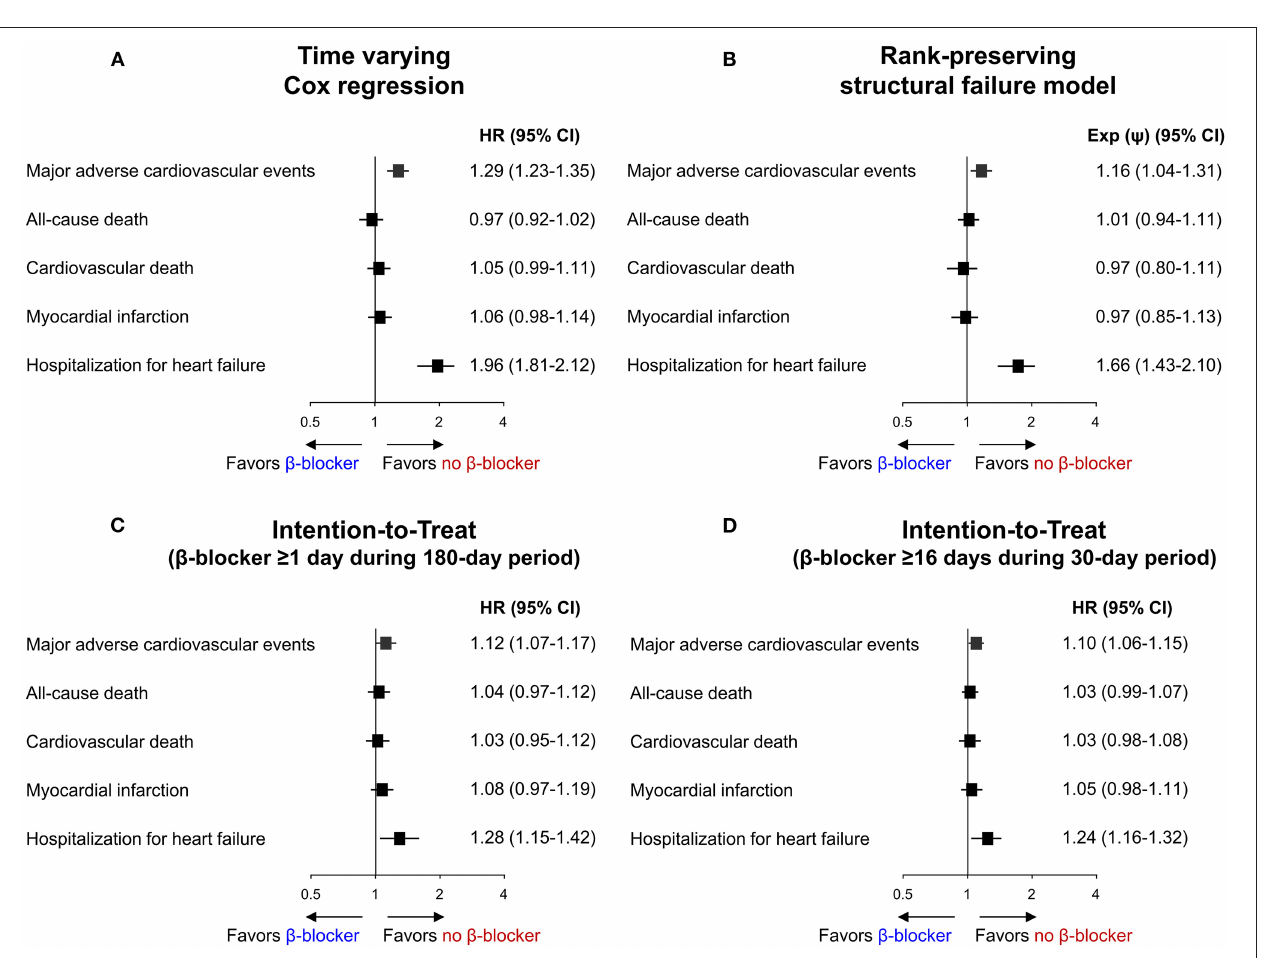
FIGURE 5 | Sensitivity analysis for primary and secondary outcomes. Risk of primary and secondary outcomes according to beta-blocker treatment analyzed by (A) Time varying Cox regression, (B) Rank-preserving structural failure model, and (C,D) Intention-to-Treat method. CI, confidence interval; HR, hazard ratio. Exp ( ψ ) indicates an increase/decrease in survival in the non-treatment